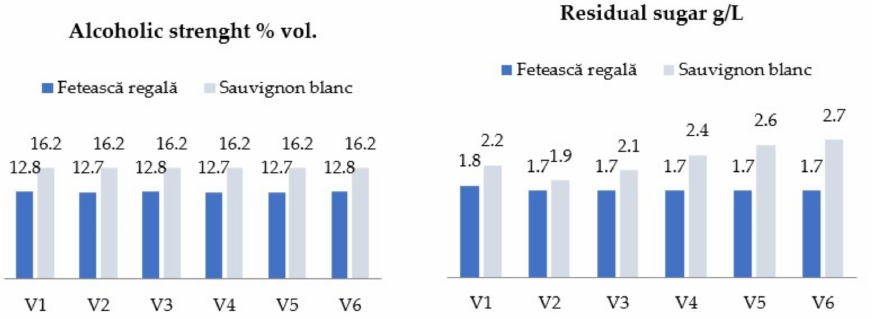
Figure 1. Alcoholic strength and residual sugar of experimental wines. V1—Endozym Thiol ® , AEB; V2—Endozym β -Split ® , AEB; V3—Zymovarietal aroma G ® , SODINAL; V4—Endozym Ice ® , AEB; V5—Zimarom ® , BSG WINE; V6—control sample, no